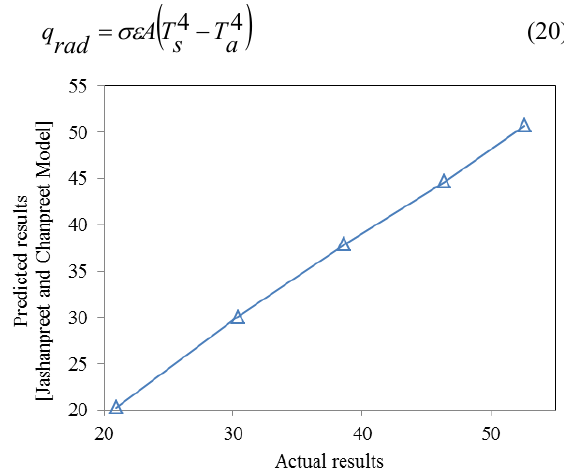
Figure 11. Actual versus predicted results of the newly proposed model of Nusselt number for numerical convection around vertical tube